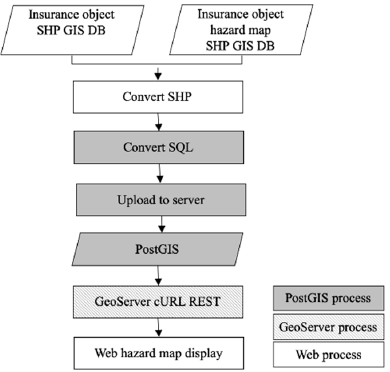
Figure 9. Spatial data upload process.